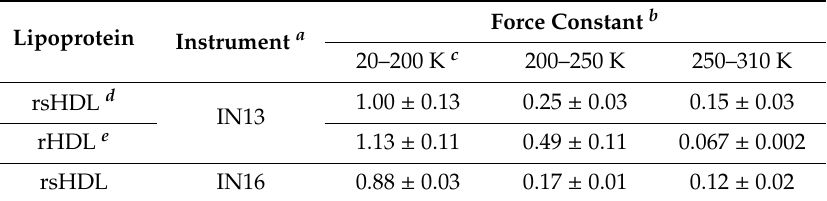
Table 1. E ff ective force constants for particle dynamics calculated from average mean square displacement for various temperature